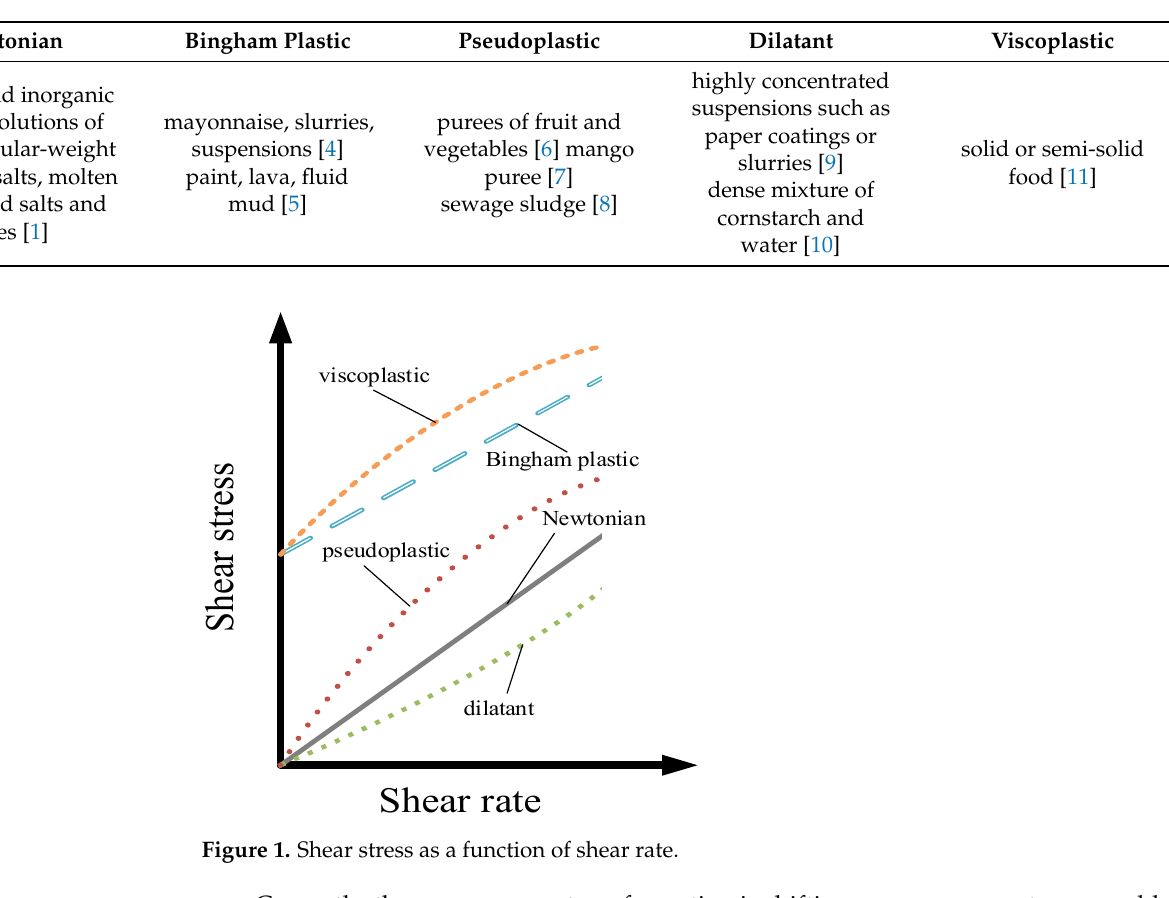
Table 1. Examples of each type of fluid.